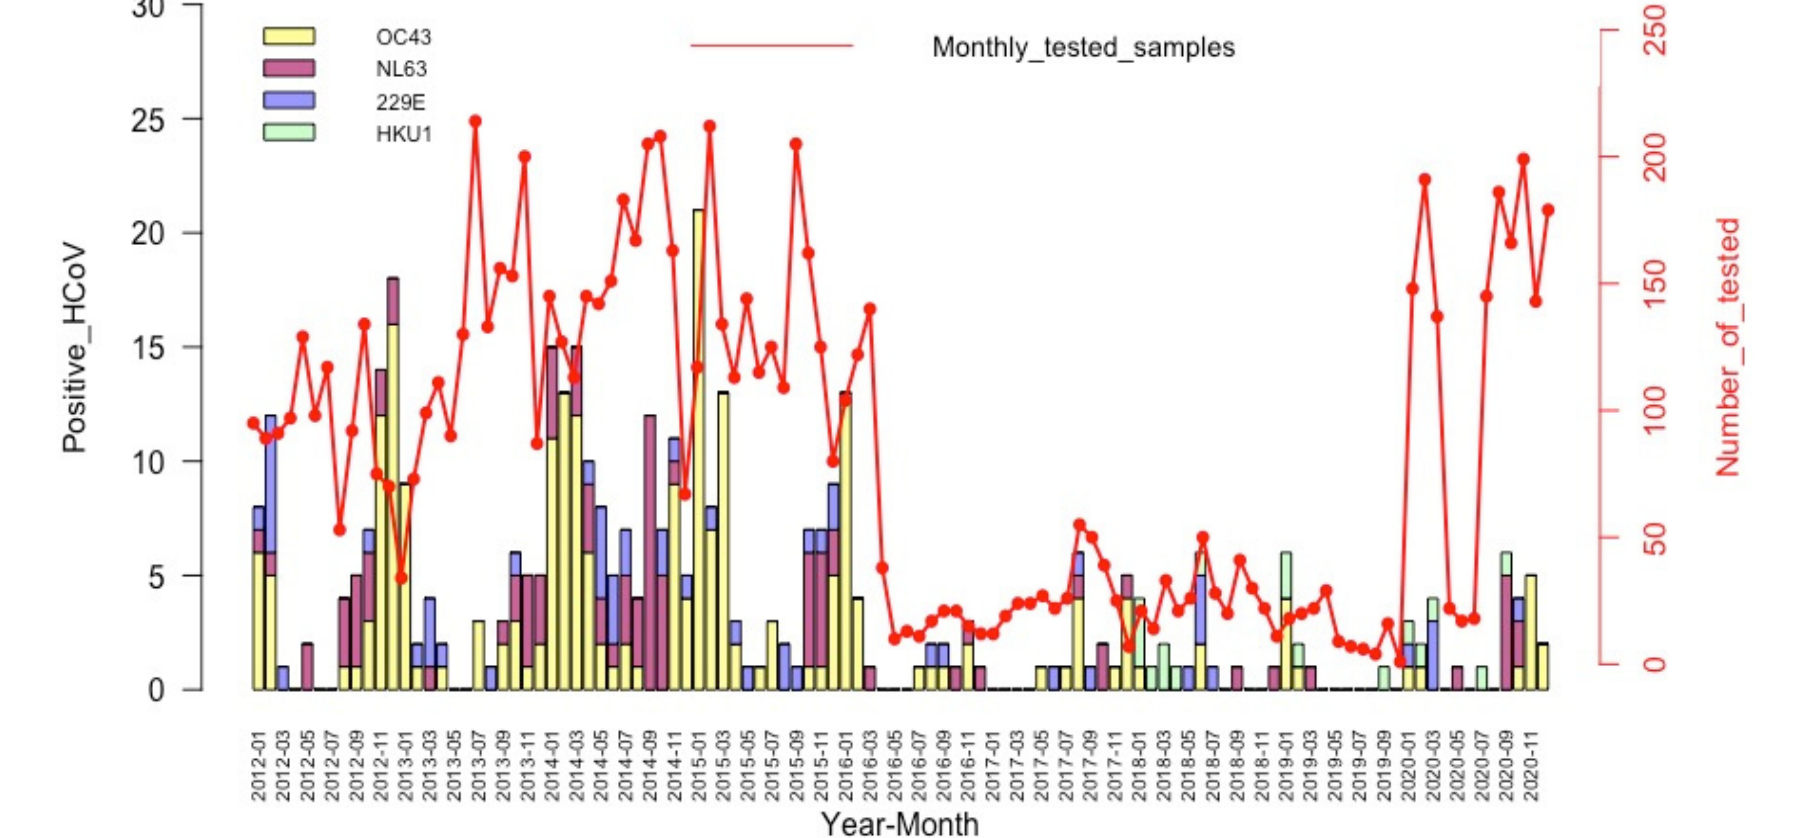
Figure 2. Temporal distribution of the HCoV detections among patients with an influenza-like illness, by month and year.